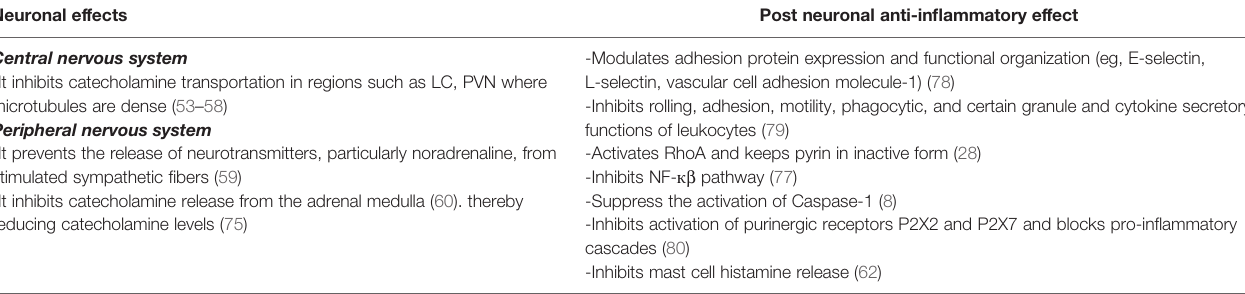
TABLE 1 | The effects of colchicine on neuronal and post neuronal